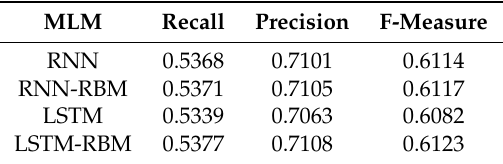
Table 7. Results for MLMs on the real piano of